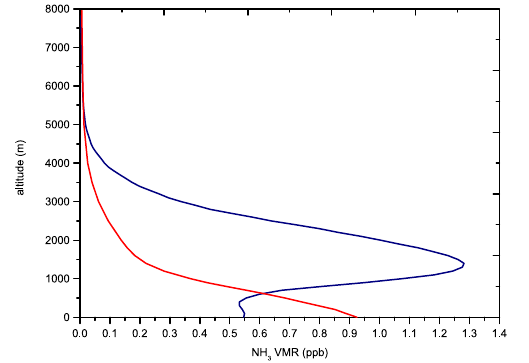
Fig. 3. NH 3 GEOS-Chem model profiles above a source area (red) and transported above sea (blue), used as reference for the radiative transfer simulations.